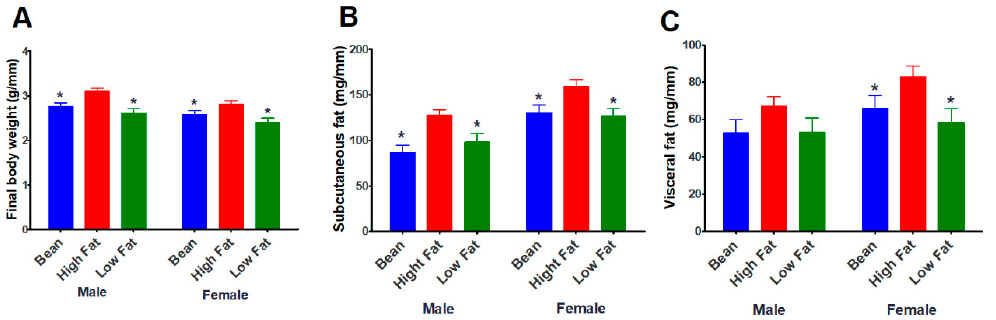
Figure 2. Effect of bean consumption on body weight and adiposity (Experiment 1). ( A ) final body weight; ( B ) subcutaneous fat; ( C ) visceral (mesenteric) fat; Units are g or mg of mass divided by length of tibia in mm. Factorial ANOVA with time on diet (TOD) as a covariate. Final body weight: sex p = 0.0012, diet p < 0.0001, interaction p = 0.6952, TOD, not significant (ns); Subcutaneous fat: sex p < 0.0001, diet p < 0.0001, interaction p = 0.6186, TOD, ns; Visceral (mesenteric) fat: sex p = 0.0417, diet p = 0.0058, interaction p = 0.7208, TOD, ns; Post hoc comparisons, * different relative to high-fat diet within gender ( p ≤ 0.05).